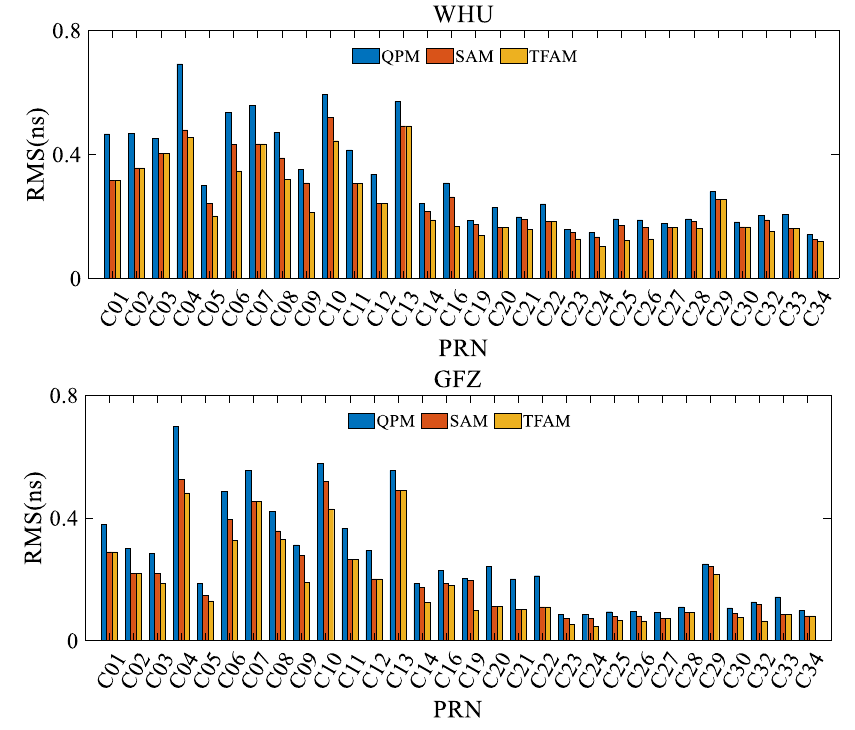
Figure 8. Mean RMS of the QPM, the SAM, and the TFAM fitting residuals.